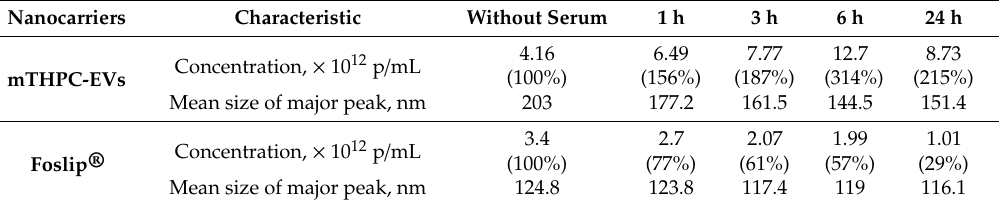
Table 1. The behavior of mTHPC-EVs and Foslip ® exo-free murine plasma determined by NanoSight. Nanocarriers